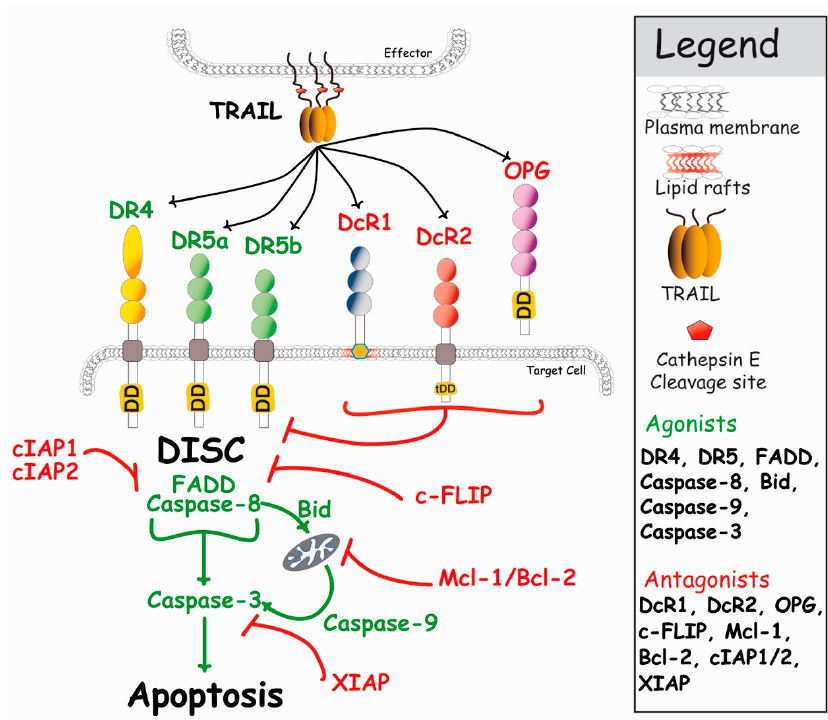
Figure 3. Simplified schematic representation of the main events regulating TRAIL-induced apoptosis. DR4 and DR5 agonistic receptors are able to recruit FADD and caspase-8 upon TRAIL stimulation, leading to apoptosis (see text for detail). In the presence of antagonist receptors, TRAIL-induced cell death is restrained, either due to competition for TRAIL binding (DcR1 and OPG) or steric hindrance, leading to reduced caspase-8 activation (DcR2, see Merino et al., 2006 [47], and Shirley [41]). Within the cytoplasm, the inhibitor c-FLIP, as well as Bcl-2 family members, can also restrain caspase activation and apoptosis, leading to cell resistance to TRAIL-induced cell death [48]. Endogenous TRAIL is naturally found associated with membranes of activated immune cells, and as such, is extremely potent in inducing apoptosis of unwanted cells [25,49–52]. Like most members of the TNF superfamily, TRAIL can be cleaved from the membranes by proteases, including